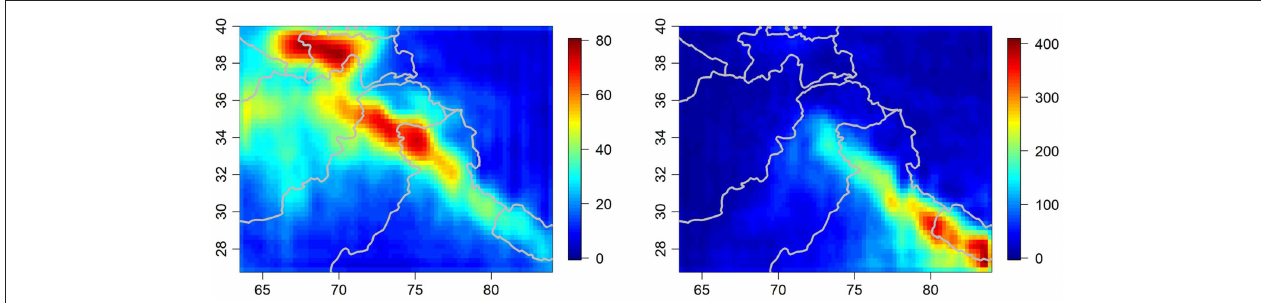
FIGURE 7 | Ten-year averaged shared product (in mm) for winter months (December/January/February) on left. Ten-year averaged shared product (in mm) for summer months (June/July/August) on right. Note that the two plots contained in this figure use different scales.